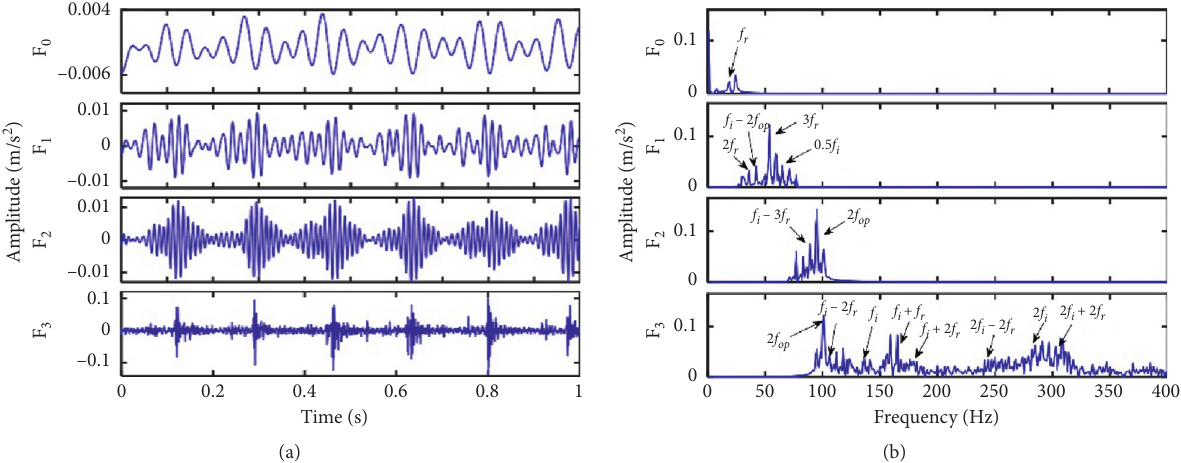
Figure 10: Inner race fault characteristics: (a) modal components of inner race fault signal using EWT and (b) their associated spectra.